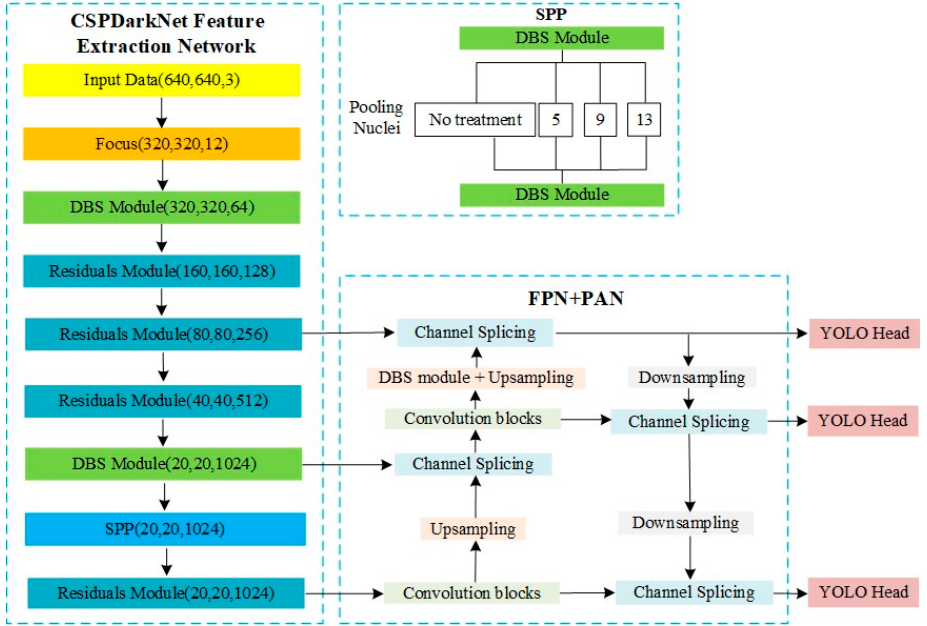
Figure 4. YOLOv5 backbone feature extraction network.